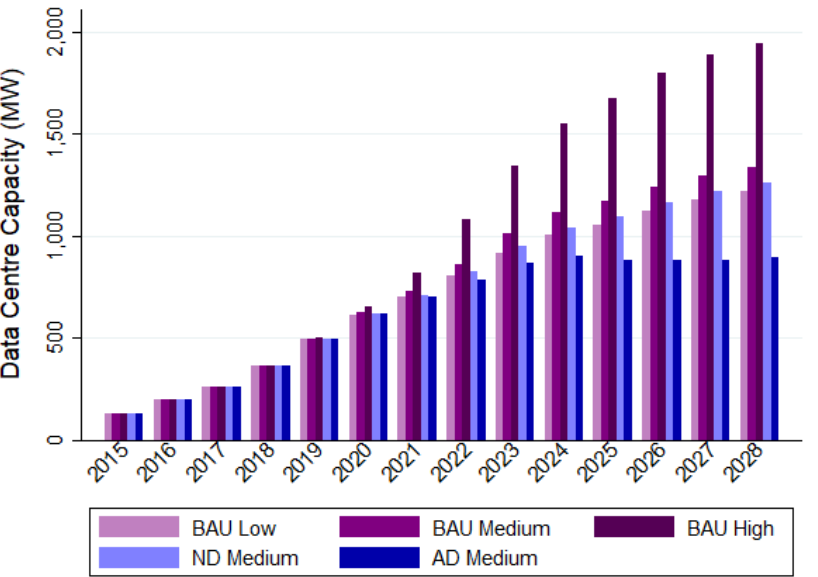
Figure 3. Data centre sector capacity (MW). Source: Author’s calculations based on EirGrid [53] data. Note: Capacities in MW, no capacity factor applied.